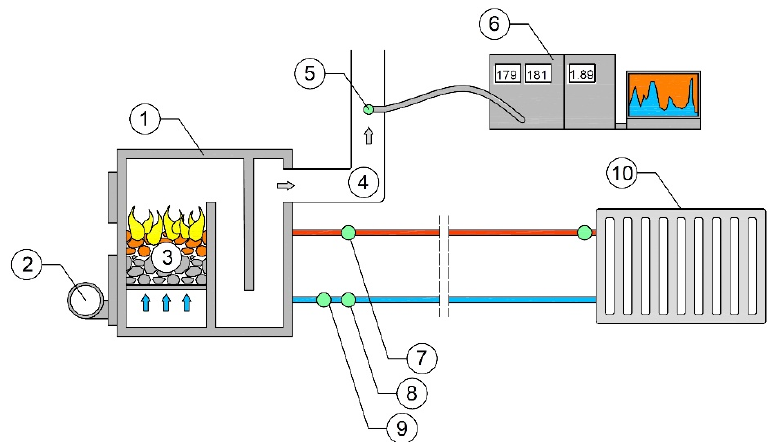
Figure 1. Diagram of the tested boiler with the measurement system, where: 1—Defro Optima Comfort boiler, 2—fan, 3—fuel burned, 4—chimney, 5—exhaust gas analyzer probe, exhaust gas temperature and pressure probe, 6—exhaust gas analyzer, temperature analyzer and flue gas pressure, 7—hot water temperature sensor, 8—cold water temperature sensor, 9—flow meter, 10—heat receivers (heaters).